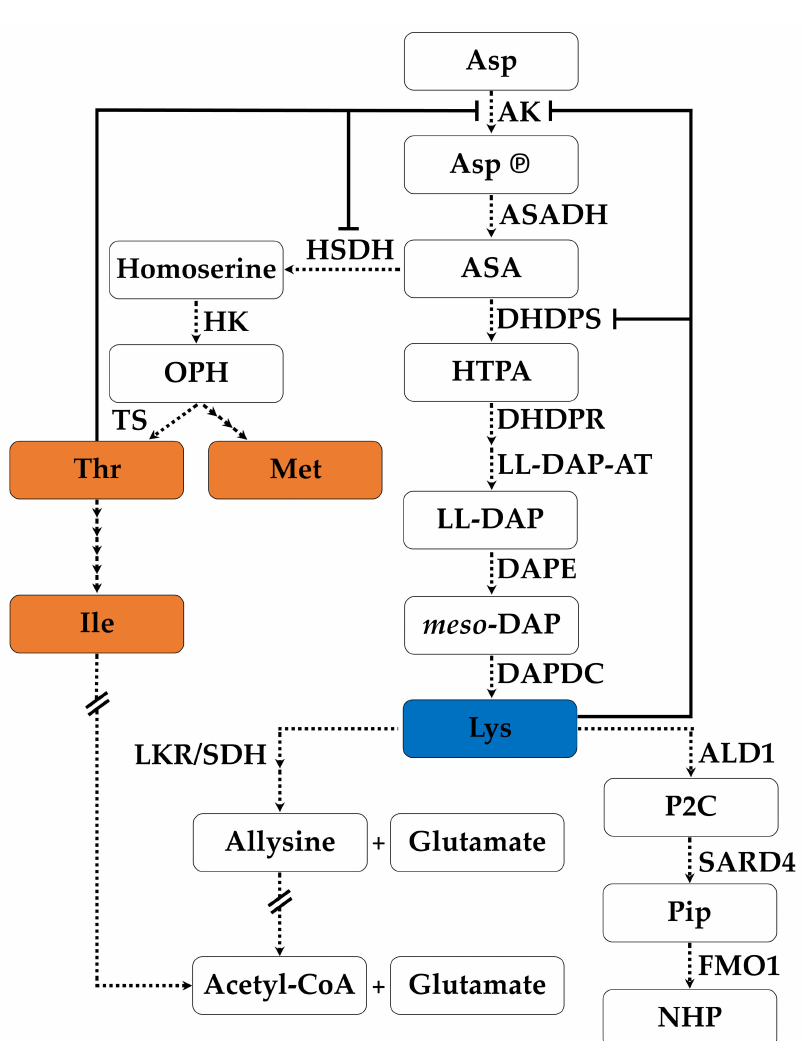
Figure 1. The Aspartate-derived amino acid pathway in plants branching into the biosynthesis of essential amino acids lysine (Lys), threonine (Thr), isoleucine (Ile) and methionine (Met). Lys is subject to catabolism into allysine and Acetyl-CoA or used for biosynthesis of Pipecolic acid